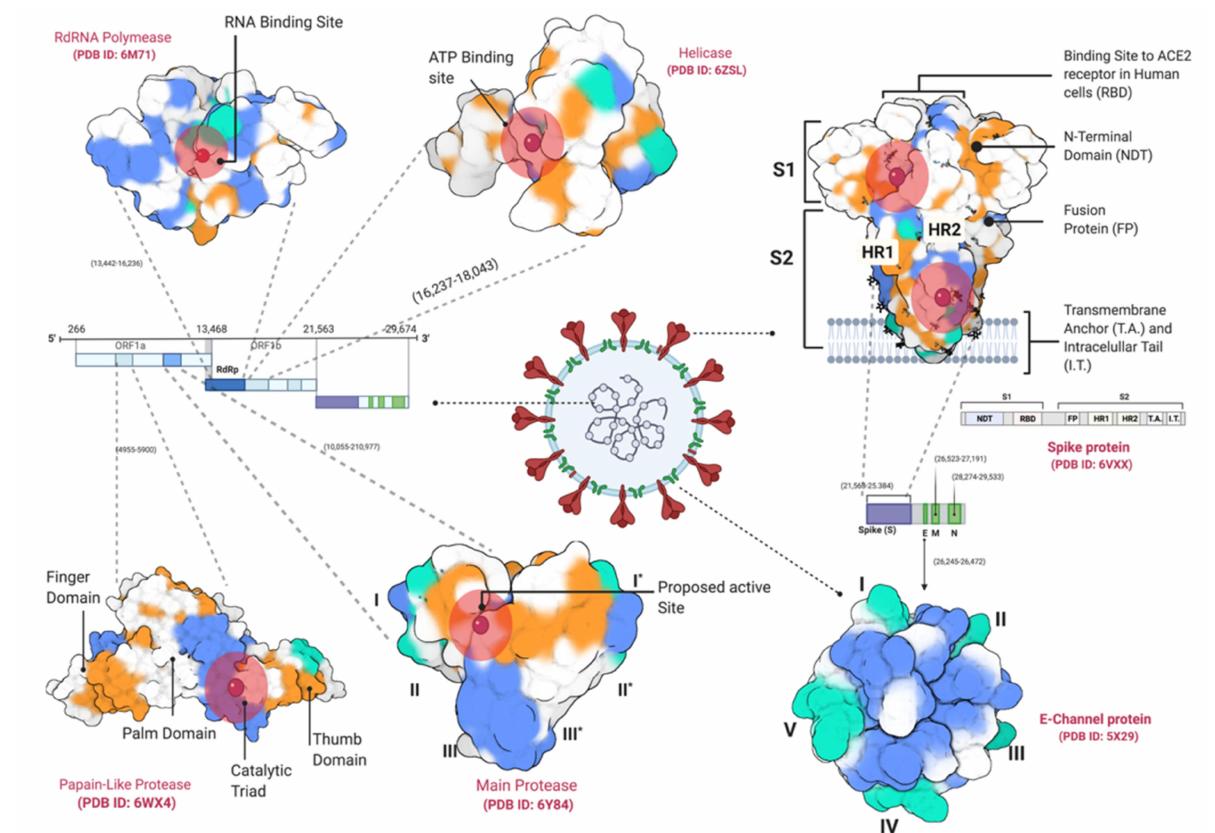
Figure 1. SARS-CoV-2 target proteins including Main Protease (M Pro , * shows domains in the second subunit of the enzyme), Papain-like Protease (PL Pro ), RNA-dependent RNA polymerase (RdRNA polymerase), Spike glycoprotein (S), helicase, and E-Channel